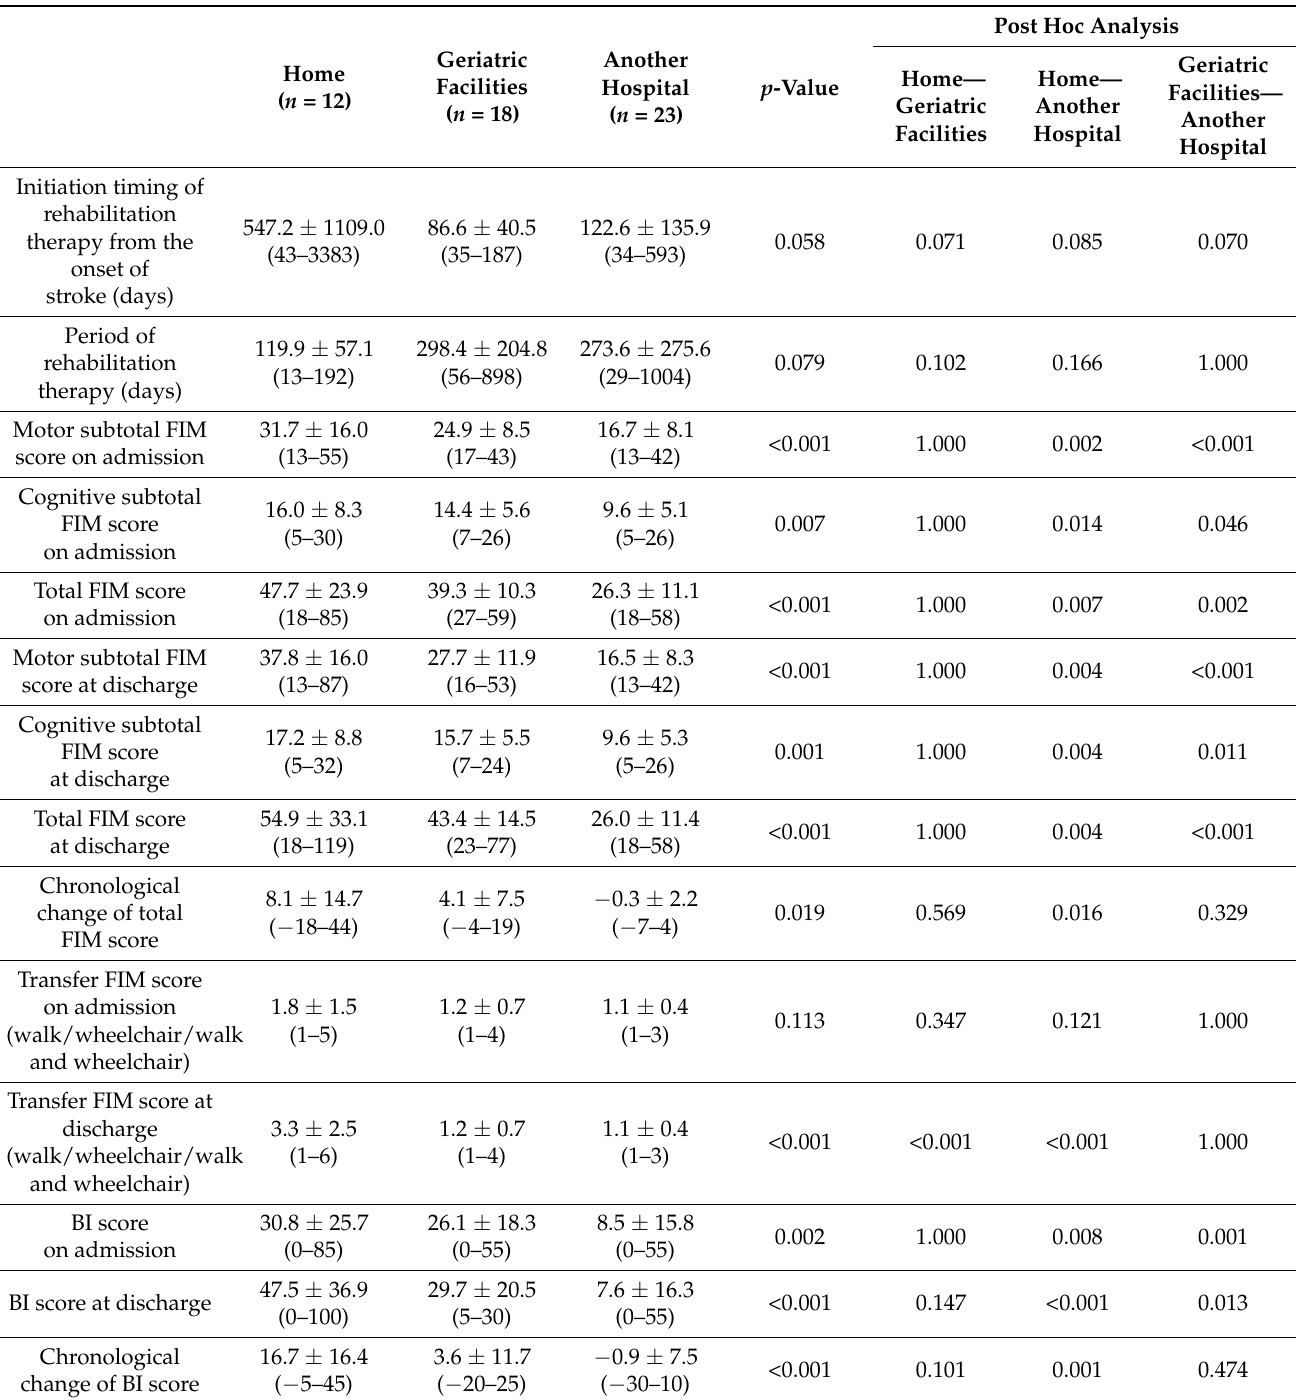
Table 1. Comparison of the fundamental information and measurements among the three groups.